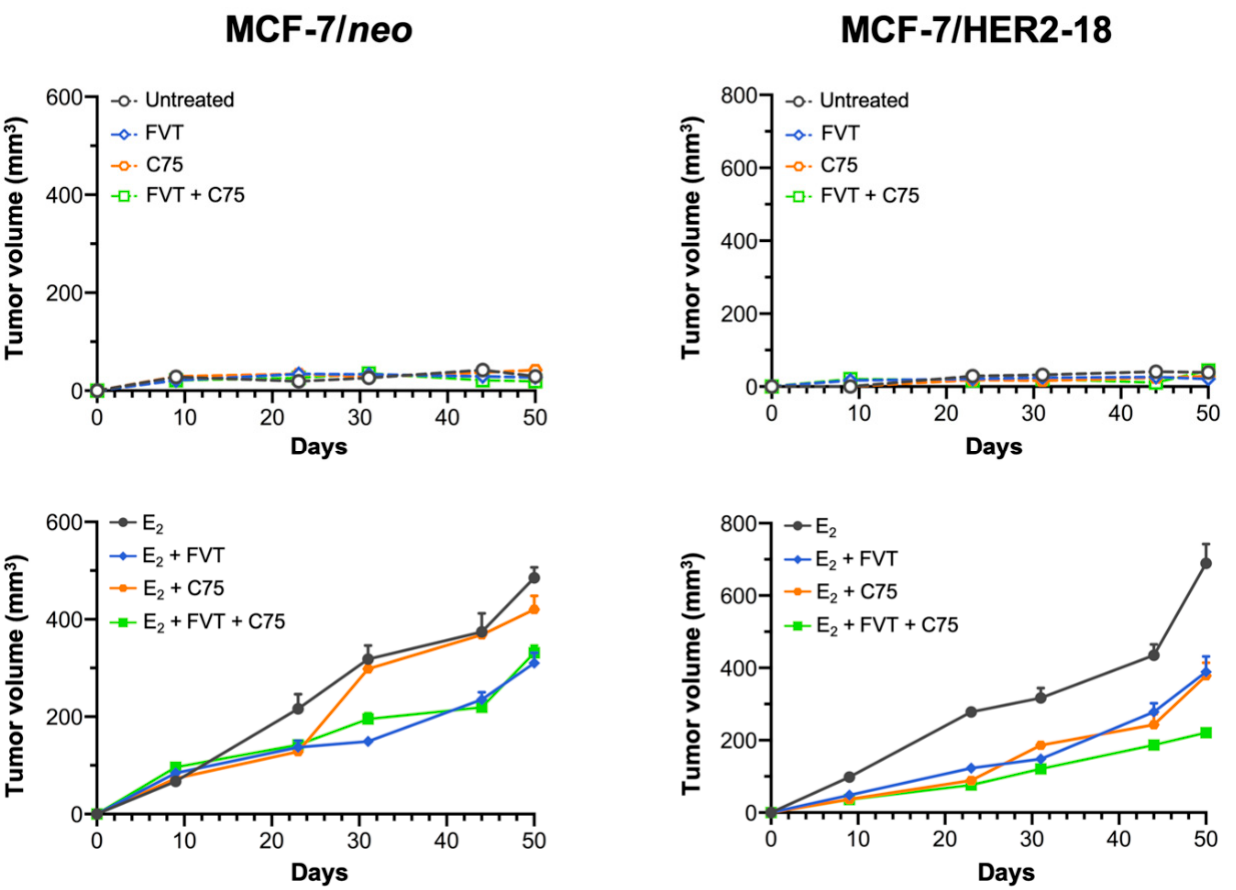
Figure 5. FASN inhibition enhances fulvestrant activity against MCF-7/HER2-18 tumors. Growth of MCF-7 and MCF- 7/HER2-18 xenograft tumors in athymic female mice treated with C75 in the absence or presence of estrogen (E 2 ) or fulvestrant (FVT). The maximum length for each treatment was 50 days. Results are presented as the mean tumor volume ± S.D. ( n = 10 mice/experimental group).